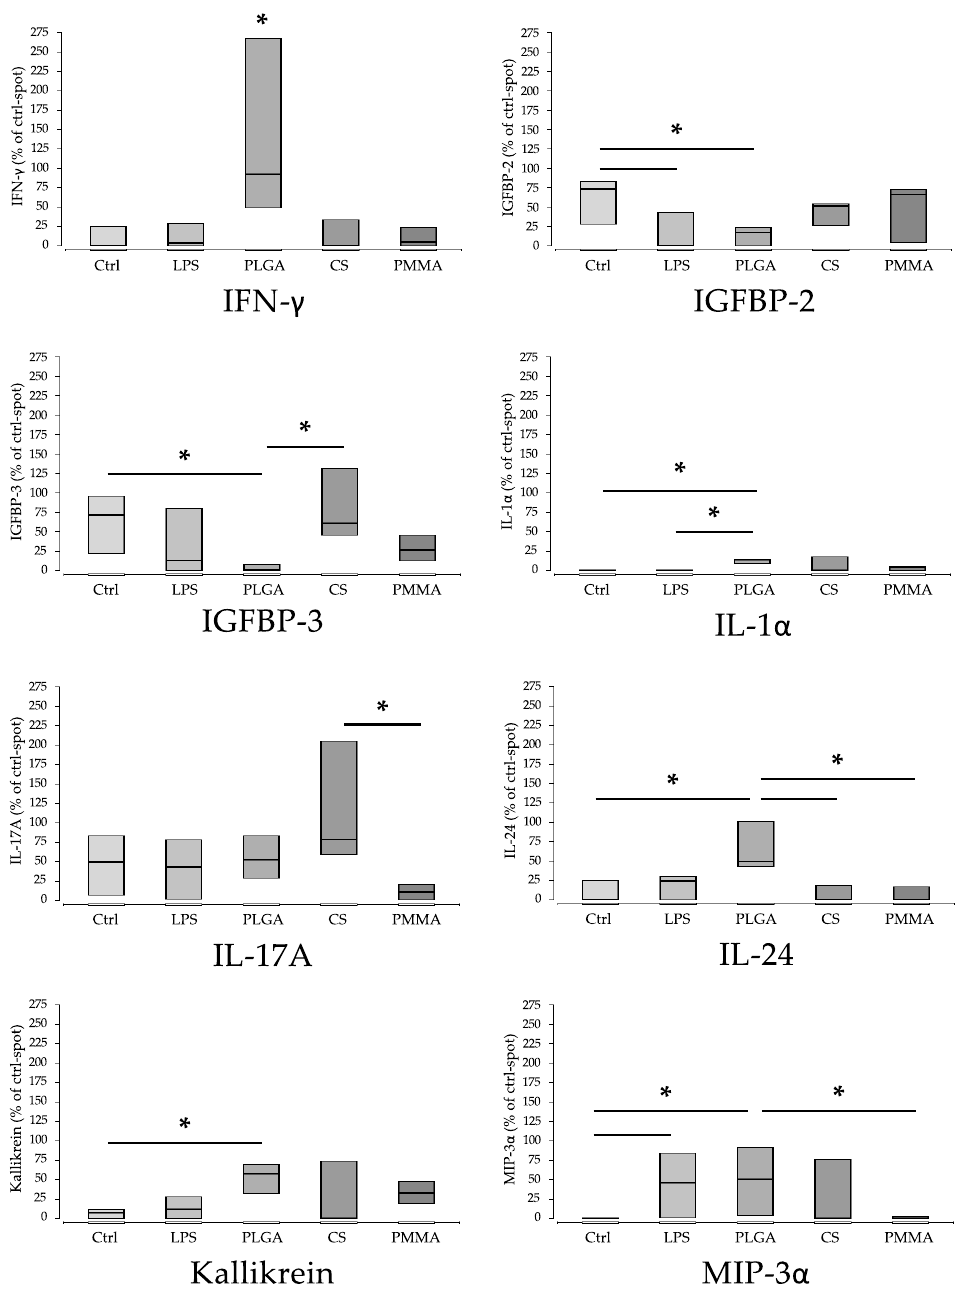
Figure 6. Parameters with explorative significant differences in non-parametric pair comparison without α correction (part 1). There is a risk of false positive significances. ‘*’ indicates explorative significance, p * < 0.05. Ctrl (control), PLGA (poly(lactic-co-glycolic acid), CS (calcium sulphate scaffold), PMMA (polymethylmethacrylate). (Ctrl: control; LPS: Lipopolysaccharide; PLGA: poly(lactic-co-glycolic acid; CS: calcium sulphate scaffold; PMMA: polymethylmethacrylate).